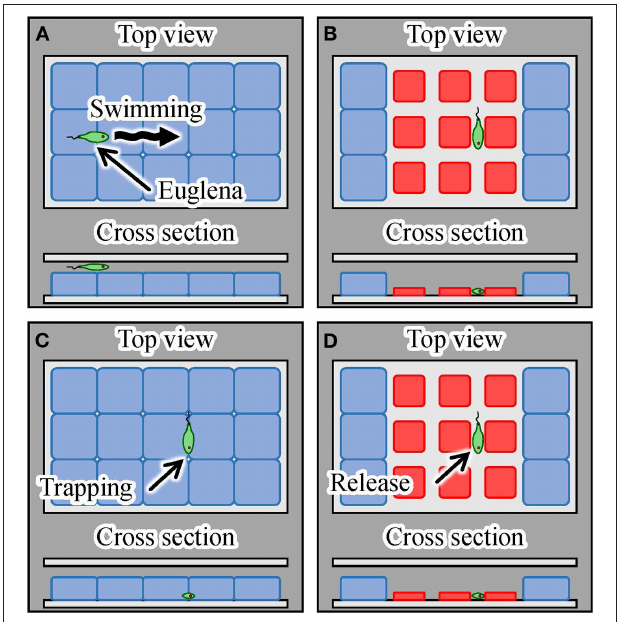
FIGURE 12 | Trapping and mechanical stimulation of a single motile cell using integrated hydrogel actuators. (A) A motile Euglena cell, (B) trapping of a Euglena cell by turning on the laser, (C) trapping and mechanical stimulation of the cell by turning off the laser, and (D) release of the Euglena cell induced by turning on the laser.